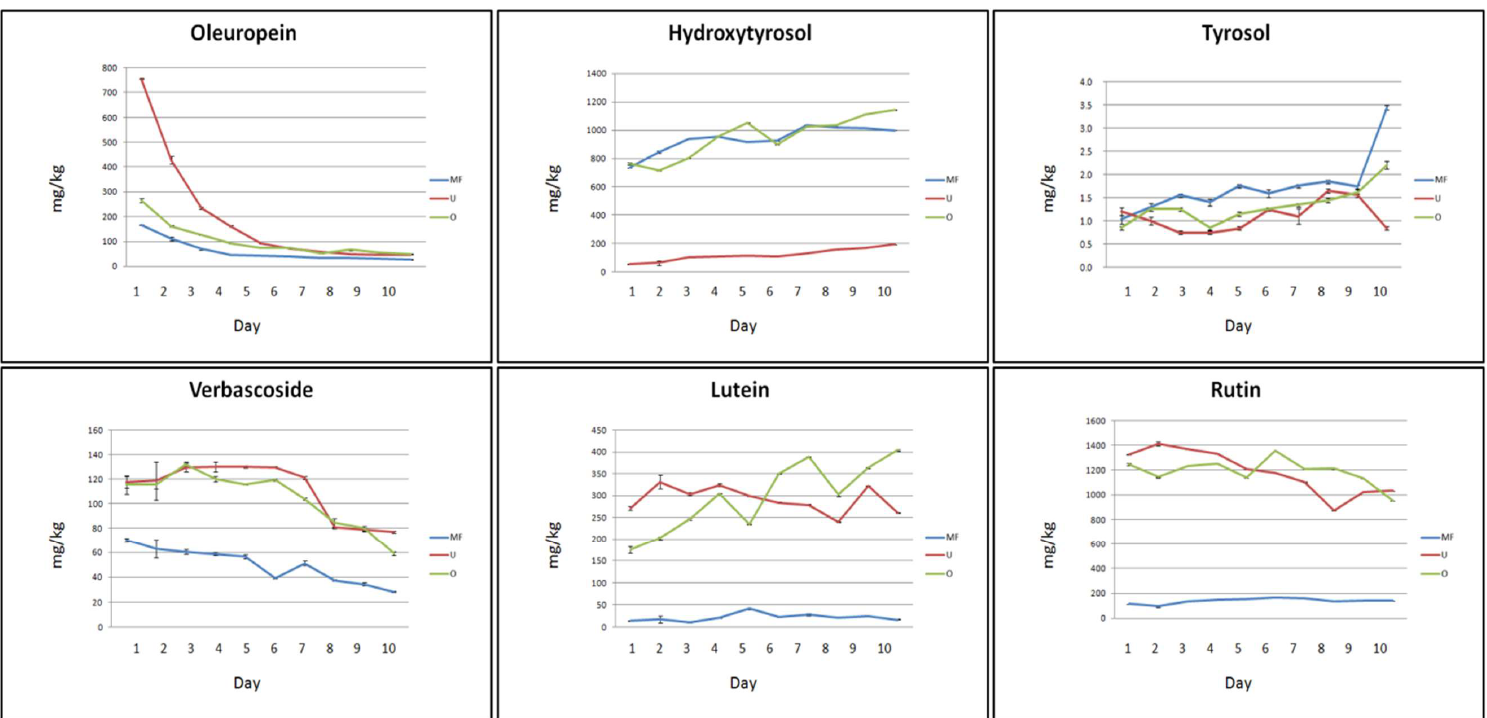
Figure 1. Trend of the concentrations of bio-active compounds in aqueous extracts of chopped olive leaves. Three types of water were tested: ultrapure (U), microfiltered (MF), and osmosis-treated (O) water. Data are expressed as the means ± standard error of the mean (SEM) of three independent observations. Statistical results from one-way analysis of variance (ANOVA) followed by Tukey-test are provided in Table S1 in Supporting Information.